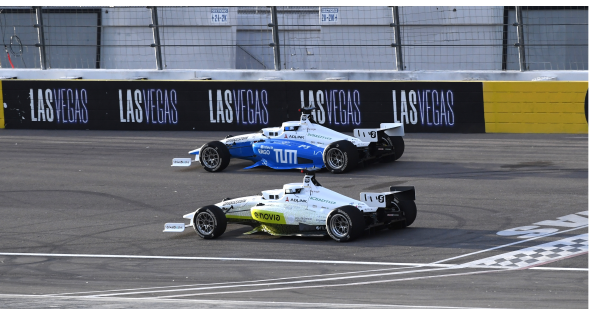
Figure 1. Dallara AV-21: Full-scale prototype of TUM Autonomous Motorsports (back) running the proposed planning algorithm at the LVMS and overtaking a dynamic